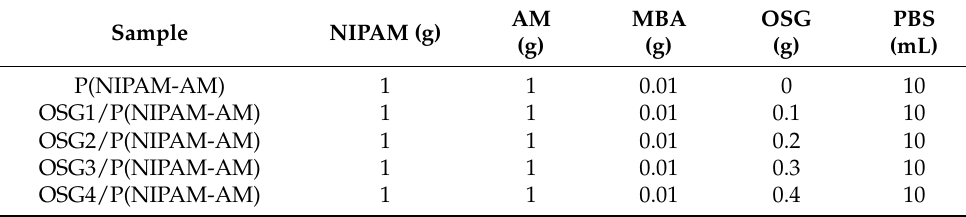
Table 1. Compositions of precursor solutions for preparing the composite